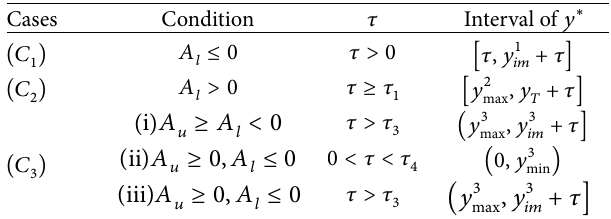
Table 1: Exact domains of the fixed point of Poincaré map for system